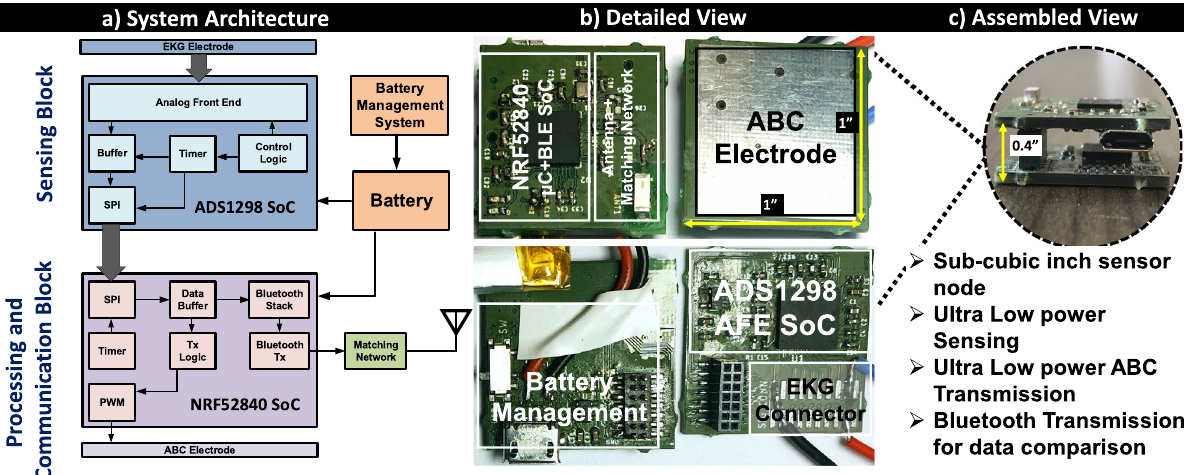
Figure 10. System Architecture of the custom-built node for biopotential acquisition through animal body communication and Bluetooth Low Energy; ( a ) Block diagram of the custom-built node, ( b ) Functional blocks depicted on the actual device, ( c ) Custom node after